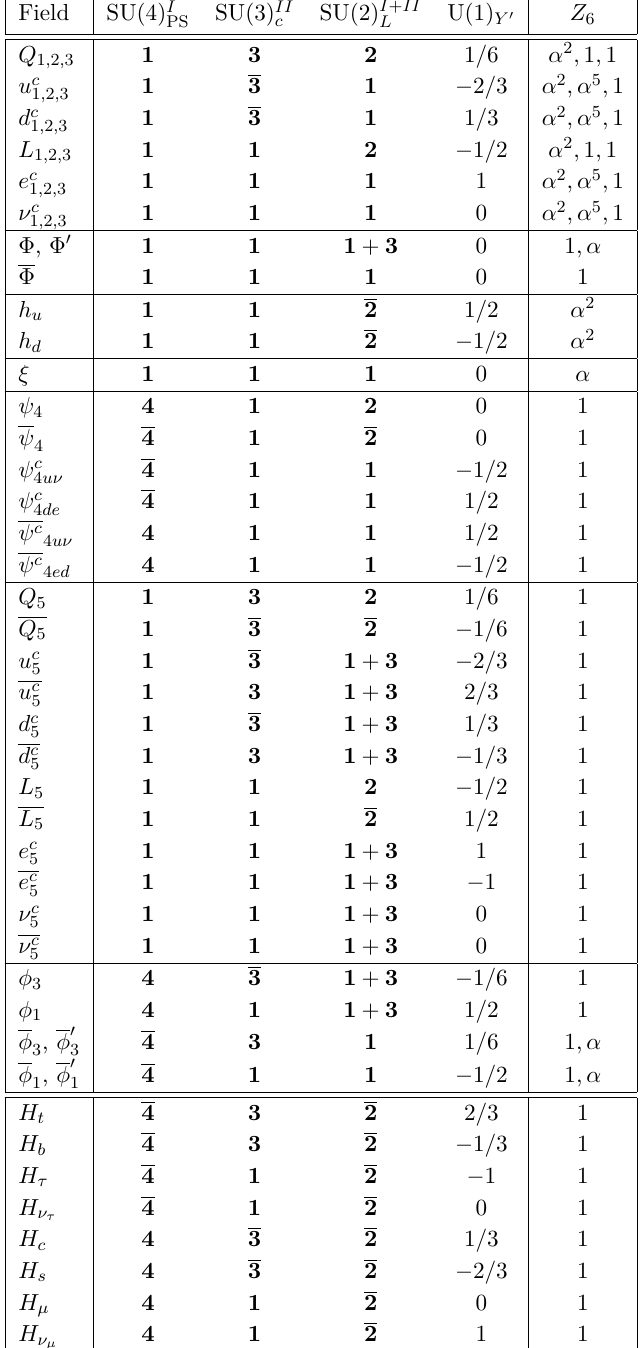
states with Y 0 = (7 / 6 , 1 / 6 , − 5 / 6) , φ 3